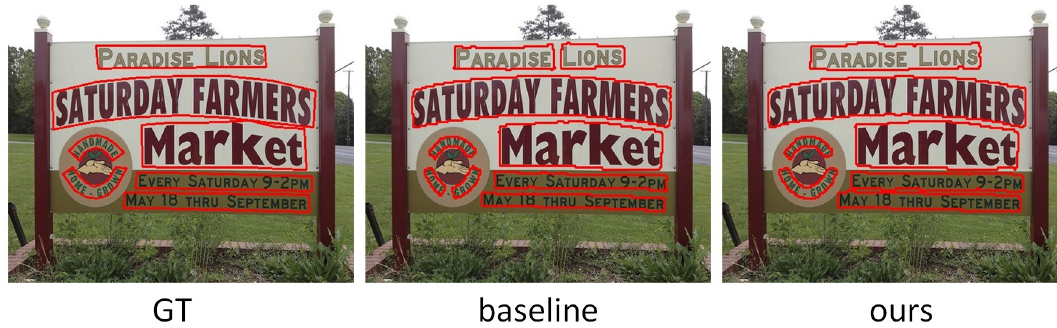
Fig 8. The visualization results of GT, baseline and our method on CTW1500.